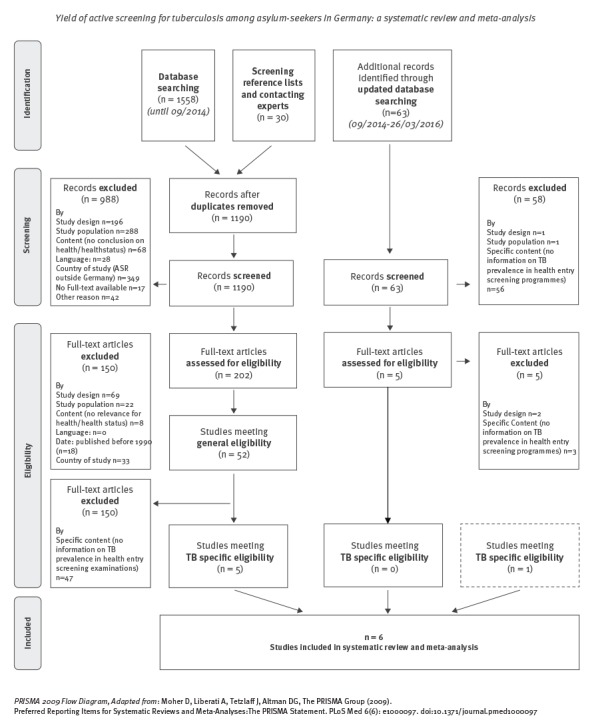
Flowchart of the review process, tuberculosis screening among asylum seekers in Germany